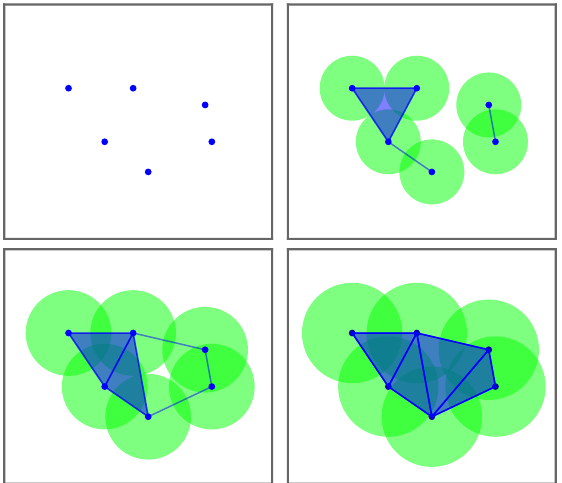
Figure 3. An example of a rips filtration with 6 points in the Euclidean plane. Note that a simplex arises when the distance between the corresponding centroids is smaller than or equal to twice the